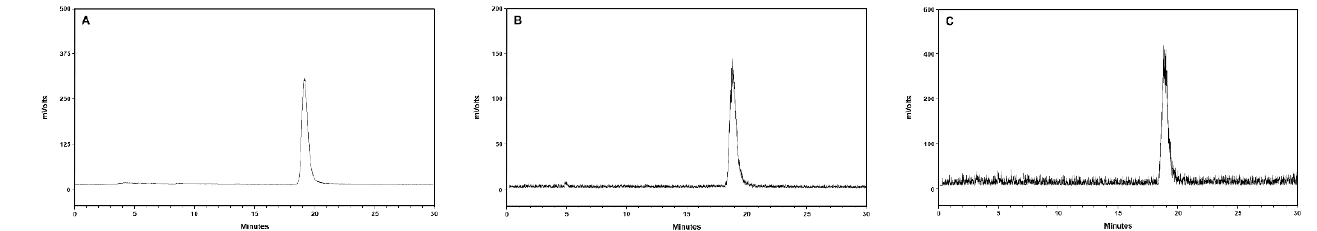
Figure 6. HPLC chromatograms of the brain homogenates obtained at 5 and 30 min after injection of [ 18 F] 1 into control mice. ( A ) [ 18 F] 1 ; ( B ) brain homogenates at 5 min; ( C ) brain homogenates at 30 min.